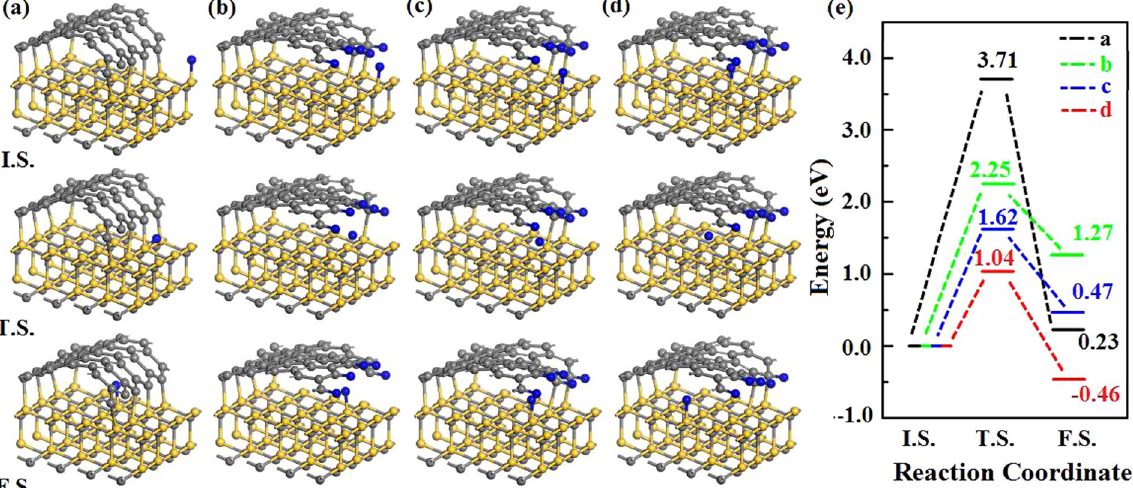
Figure 4. Reaction pathways for H atom intercalation into interface from ( a ) bare graphene edge, ( b ) from passivated graphene edge by breaking covalent bond and ( c ) from passivated graphene edge without breaking covalent bond. ( d ) Reaction pathway for H atom diffusion under the interface. ( e ) Energy barriers of H diffusion in ( a , b , c ) and ( d ).